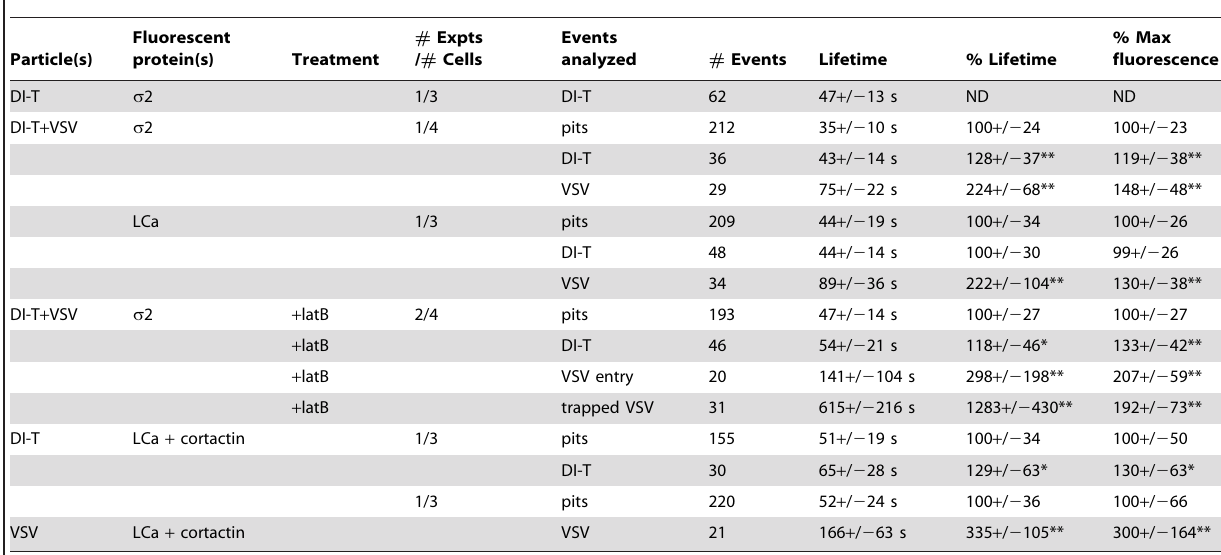
Table 1. Summary of kinetic and fluorescence intensity